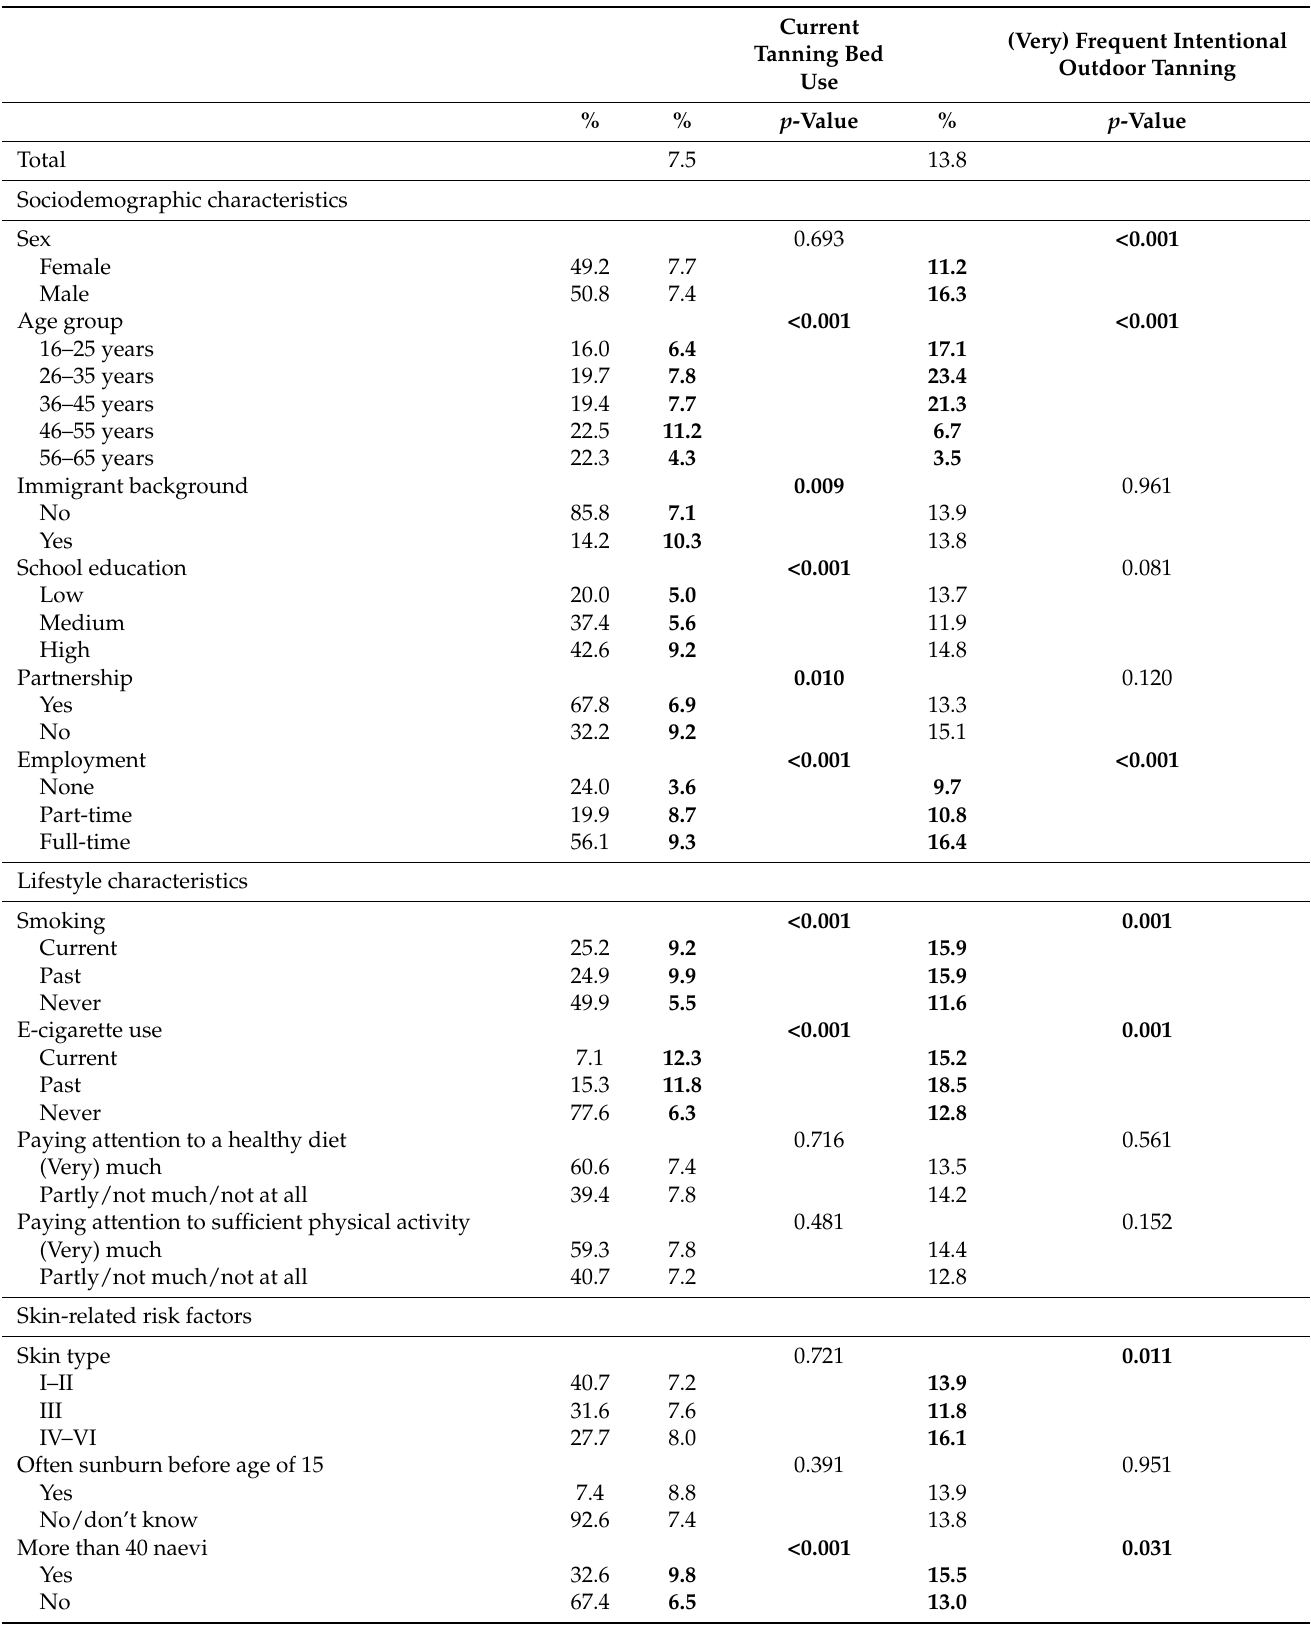
Table 1. Tanning bed use and (very) frequent intentional outdoor tanning in the German population (aged 16 to 65 years) by individual